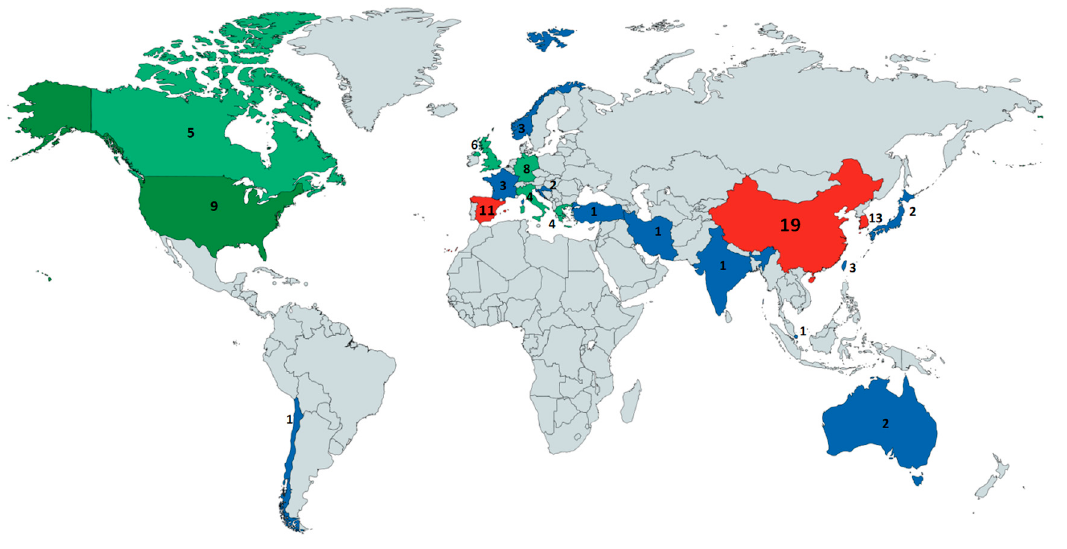
Figure 2. The number of studies on maritime digitalization produced by country (generated using https://mapchart.net/). Countries in red are those with the most papers. Those in green have produced an intermediate amount and in blue are those with the fewest number of studies.